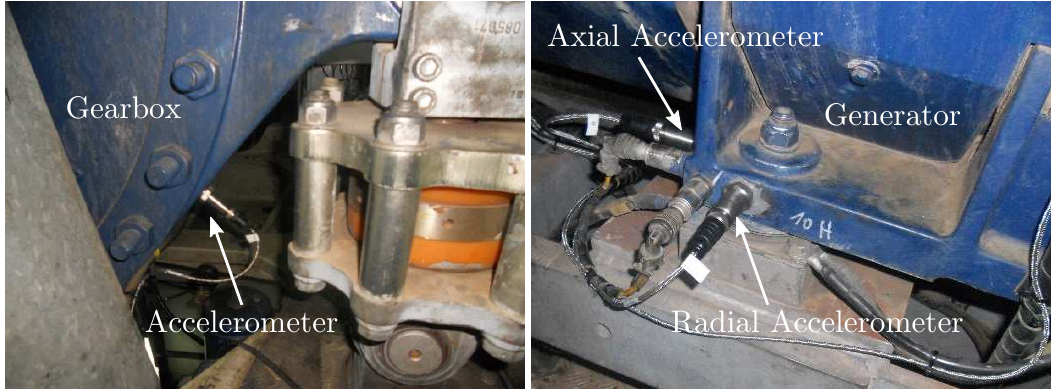
Figure 4. The radial vibration sensor installed near the planetary gear on the left and both axial and radial vibration sensors installed on the generator drive end on the right.